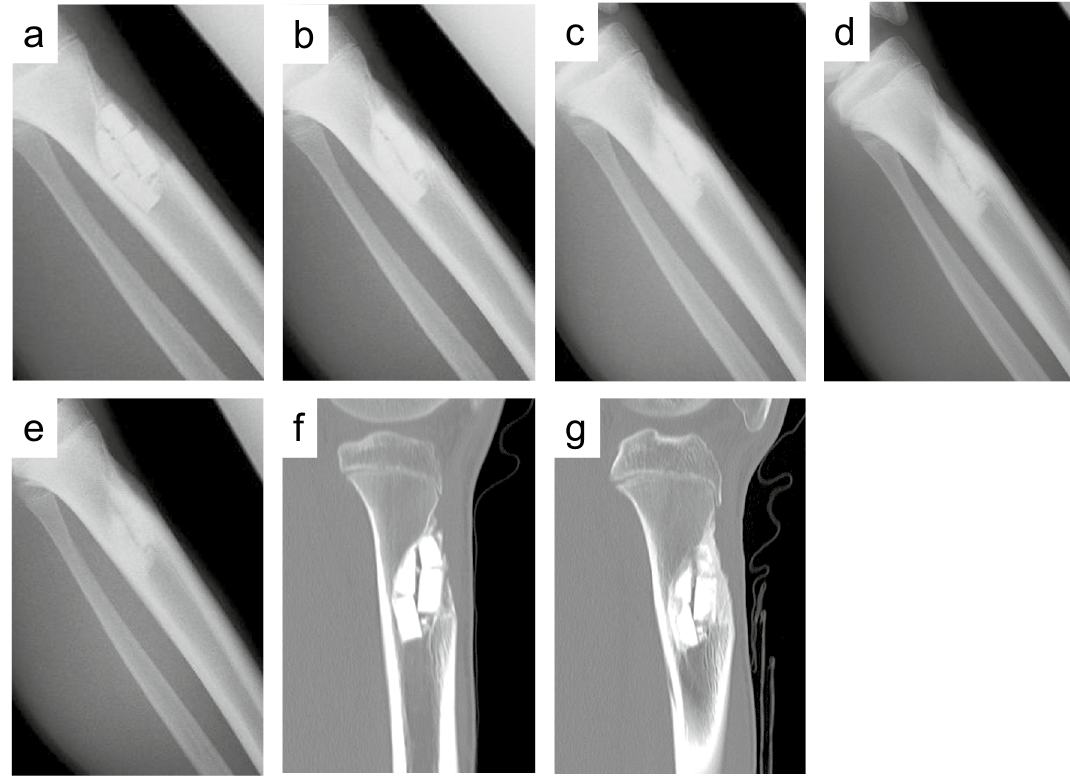
Figure 2. The degrees of Affinos filling the defects were classified into five stages with plain radiographs and computed tomography (CT) images in a 13-year-old boy with tibial fibrous dysplasia. ( a ) Radiograph at 1 month after surgery: the values of resorption and trabeculation were 0% and 0%, respectively. ( b ) Radiograph at 3 months after surgery: the values of resorption and trabeculation were 25% and 50%, respectively. ( c ) Radiograph at 6 months after surgery: the values of resorption and trabeculation were 75% and 75%, respectively. ( d ) Radiograph at 9 months after surgery: the values of resorption and trabeculation were 75% and 100%, respectively. ( e ) Radiograph at 12 months after surgery: the values of resorption and trabeculation were 100% and 100%, respectively. ( f ) Sagittal view of tibial CT at 3 months after surgery: the values of resorption and trabeculation were 25% and 50%, respectively. ( g ) Sagittal view of tibial CT at 9 months after surgery: the values of resorption and trabeculation were 50% and 75%,